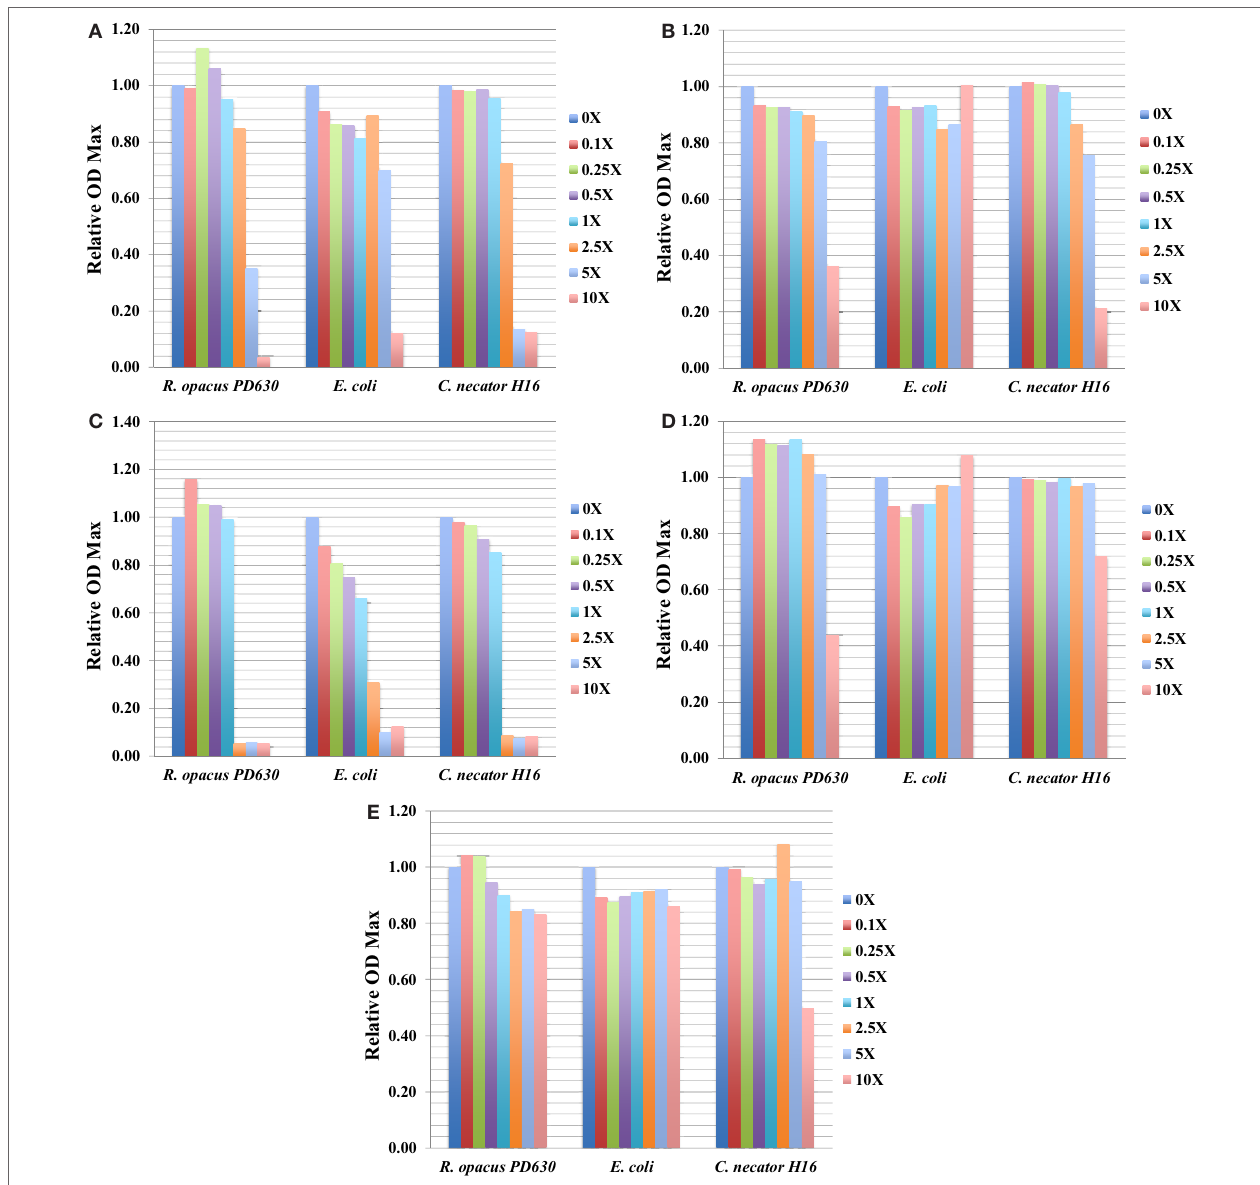
FigUre 3 | The relative OD max value for three bacterial strains grown in concentrations of toxic compounds ranging from 0 to 2.5 × concentrations for ammonium acetate (AA) (a) ; ammonium sulfate (AS) (B) ; furfural (c) ; HMF (D) ; and benzoate (e) . Growth was monitored using the Bioscreen C (BSC) instrument with three technical replicates. The experiments were repeated at least two times with similar